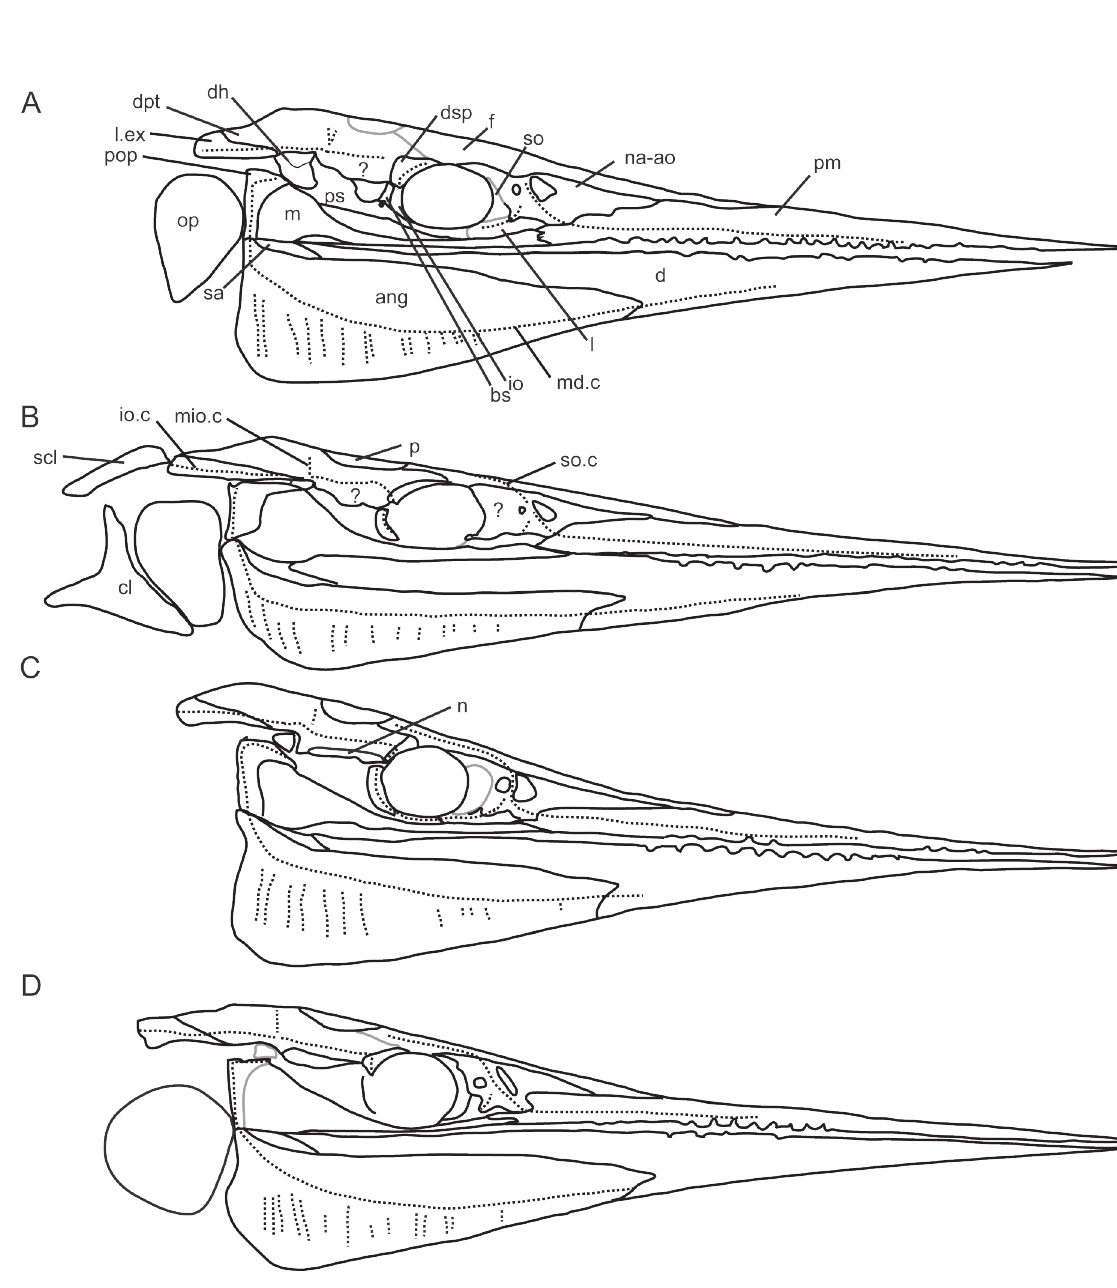
Fig. 2. Reconstruction of the dermal skull in Early Jurassic saurichthyids. A . Saurorhynchus brevirostris (Woodward, 1895). B . Saurorhynchus anningae sp. nov. C . Saurorhynchus hauffi sp. nov. D . Saurorhynchus acutus (Agassiz, 1844). Not to scale. Dashed lines indicate sensory canals, grey lines indicate bones that were present but where the exact location of the sutural contact is unclear, and question marks indicate areas of uncertainty. Abbreviations: ang = angular; bs = basisphenoid; cl = cleithrum; d = dentary; dh = dermohyal; dpt = dermopterotic; dsp = dermophenotic; f = frontal; io = infraorbital; io.c = infraorbital sensory canal; l = lacrimal; l.ex = lateral extrascapular; m = maxilla; md.c = mandibular sensory canal; mio.c = medial branch of the infraorbital sensory canal; n = neomorph; na-ao = nasaloantorbital; op = opercle; p = parietal; pm = rostropremaxilla; pop = preopercle; ps = parasphenoid; sa = supraangular; scl = supracleithrum; so = supraorbital; so.c = supraorbital sensory